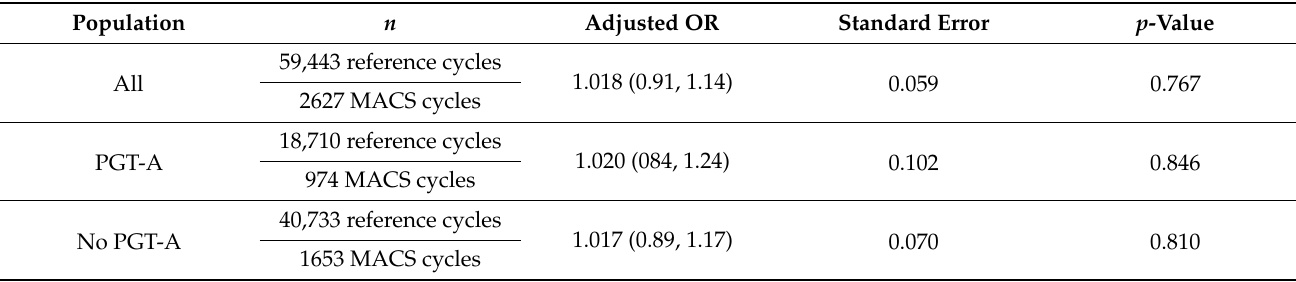
Table 3. Results from the multivariate adjusted analysis, accounting for the relationship between the use of magnetic- activated cell sorting (MACS) and the live birth rate (LBR) per cycle, once adjusted for the female patient’s age and BMI, the age of the male patient, the presence or absence of male factor infertility, the last recorded endometrial lining measurement, the transfer of the embryo at the blastocyst stage, and the fact that the embryos underwent pre-implantation genetic testing for aneuploidies (PGT-A). This table shows the adjusted odds ratio (OR) with its 95% CI, standard error, and p -value for each studied population, namely: all patients included in the database, those whose embryos underwent PGT-A and those who did